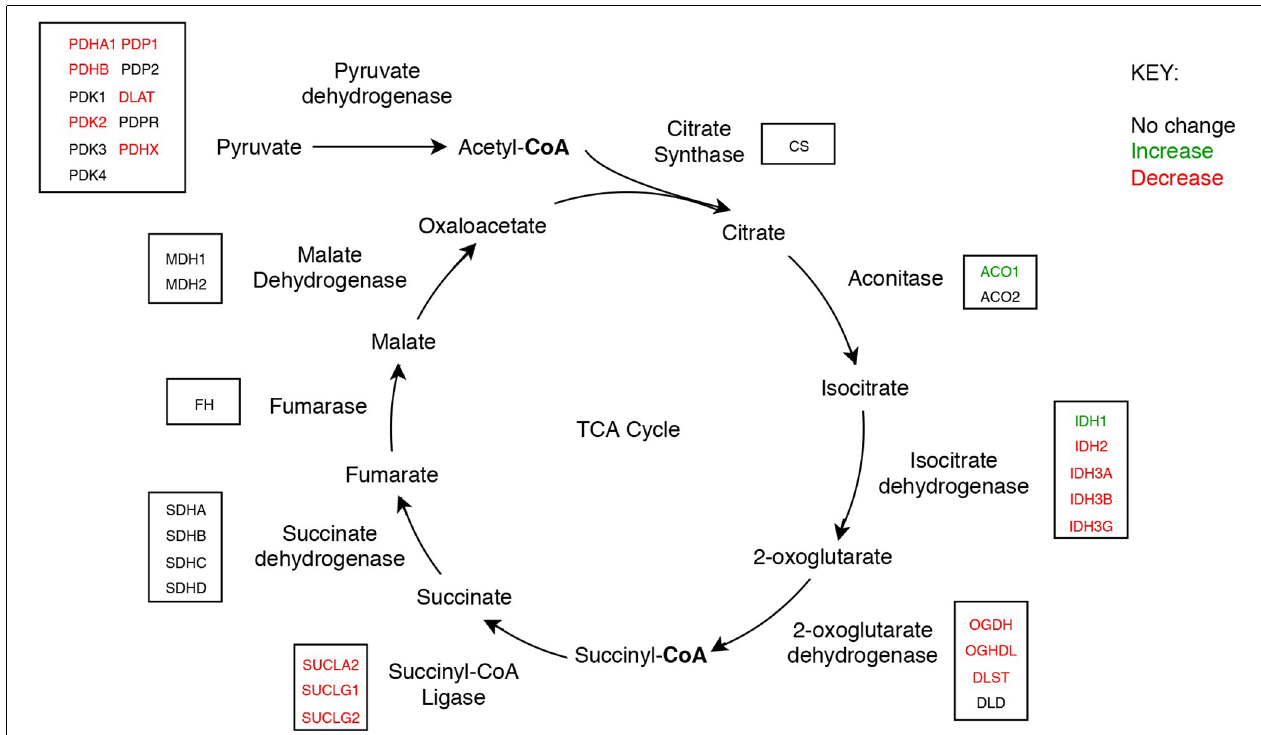
FIGURE 3 | The tricarboxylic acid cycle showing concentrations of mitochondrial enzyme molecules whose levels were found to be altered in sAD brain in this study.